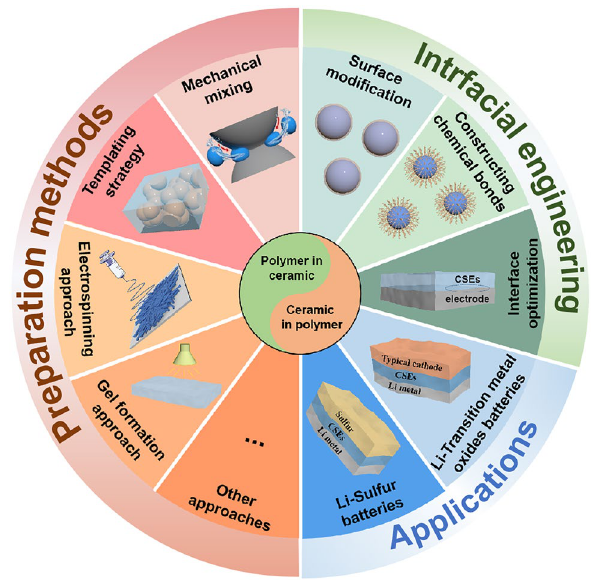
Fig. 1 The organization of this review